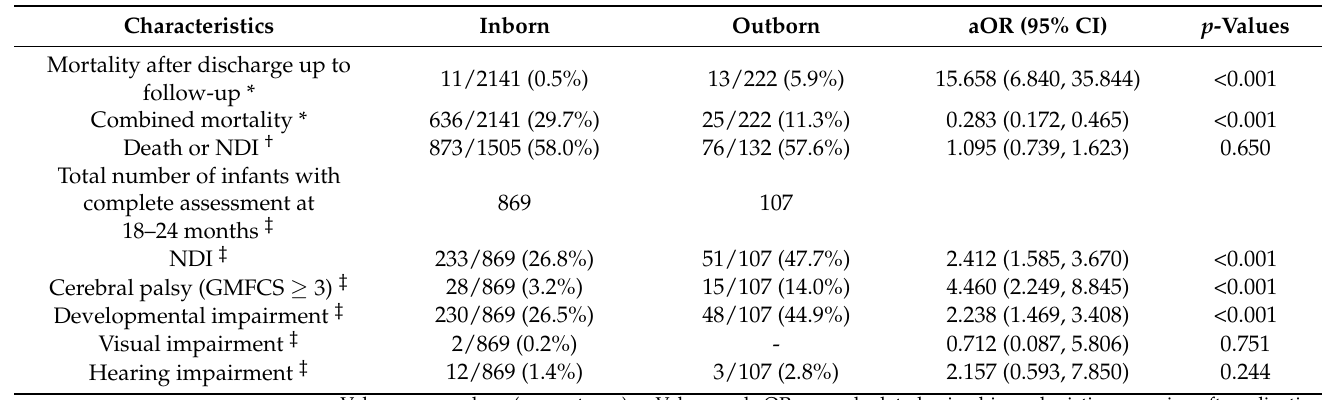
Table 3. The long-term neurodevelopmental outcome.